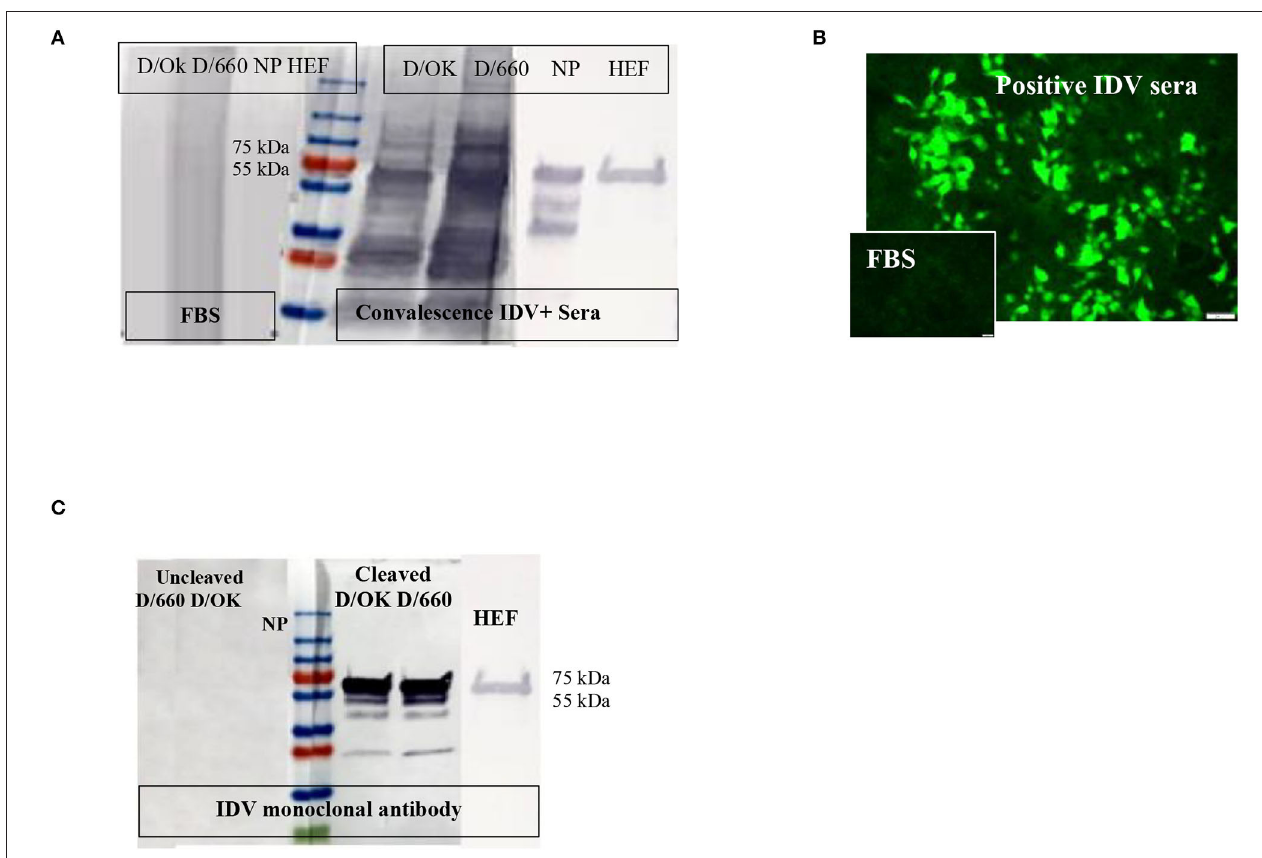
FIGURE 1 | Specificity of recombinant proteins vs. that for the whole virus at the IDV convalescent stage. (A) Specificity of recombinant proteins vs. that for the whole virus at the IDV convalescent stage. (B) IFA of IDV-infected MDCK cells using positive and negative bovine serum samples and anti-bovine fluorescein isothiocyanate (FITC) including positive convalescent bovine anti-IDV sera showing strong fluorescent staining of virus-infected cells and Negative serum sample showing no specific fluorescent staining. (C) Mapping of the IDV